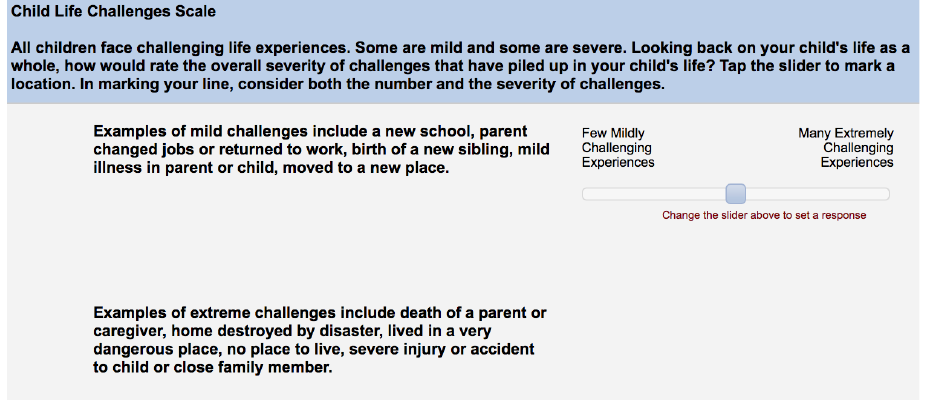
Figure 1. The Child Life Challenges Scale (tablet version).